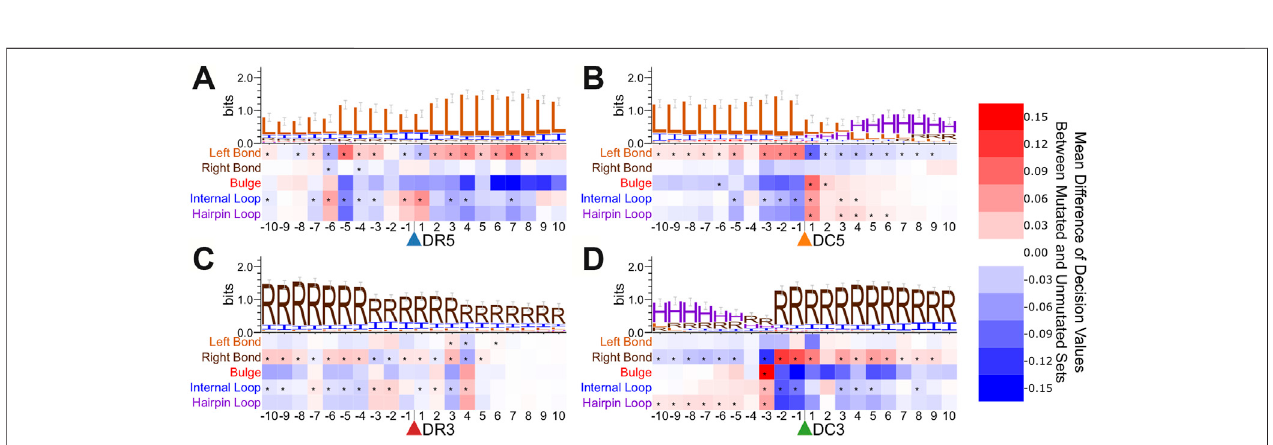
FIGURE 4 | Point mutation analysis for nucleotides surrounding cut sites in the test set. Heatmaps show the average change in decision value due to point mutations for nucleotides surrounding cleavage sites of (A) . Drosha on the 5 ′ arm, (B) . Dicer on the 5 ′ arm, (C) . Drosha on the 3 ′ arm, and (D) . Dicer on the 3 ′ arm.